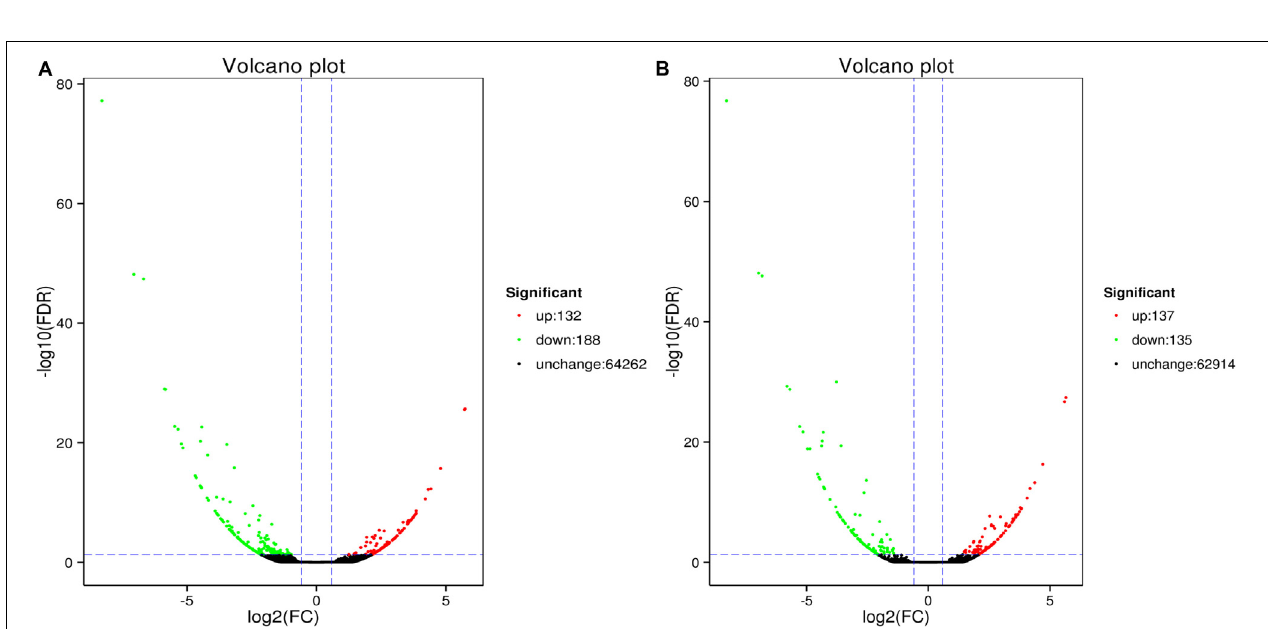
FIGURE 4 | GO classification of assembled unigenes. X -axis: GO classification, including biological process, cellular component, and molecular function, Y -axis: The left ordinate is the percentage of genes; the right ordinate is the numbers of genes.